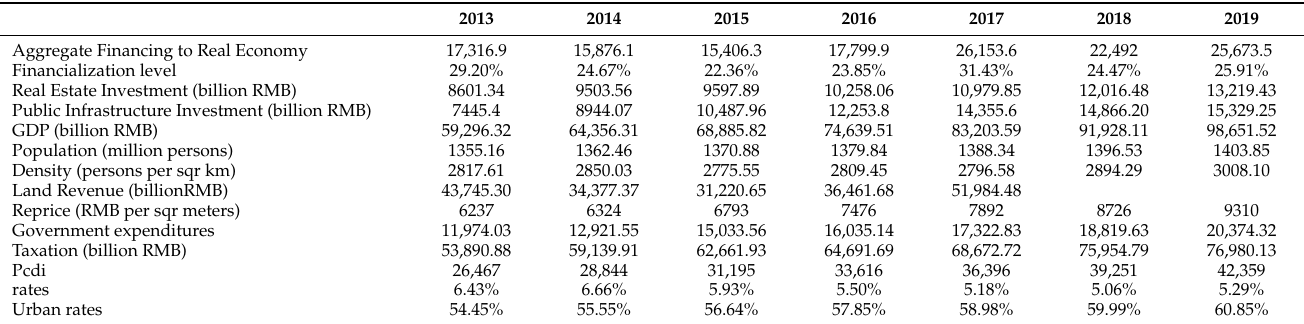
Table 2. Aggregate financing to real economy, financialization level and housing investment-to-GDP changes from 2013 to 2017 in the eastern, middle and western regions in